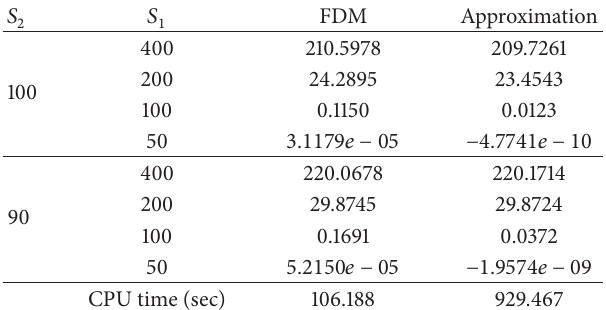
Table 1: Comparison proposed method (FDM) with analytical approximation (86).